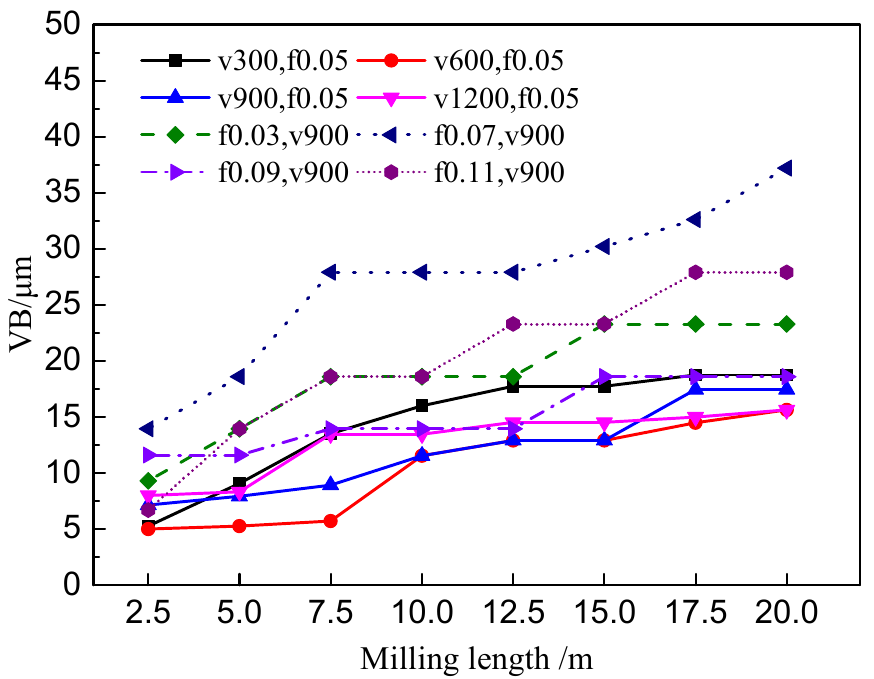
Figure 3. The change curve of VB with milling length at different cutting parameters (where V means cutting speed in m/min, F means the Feed in mm/rev, the cutting depth is 0.5 mm and cutting width is 3 mm).